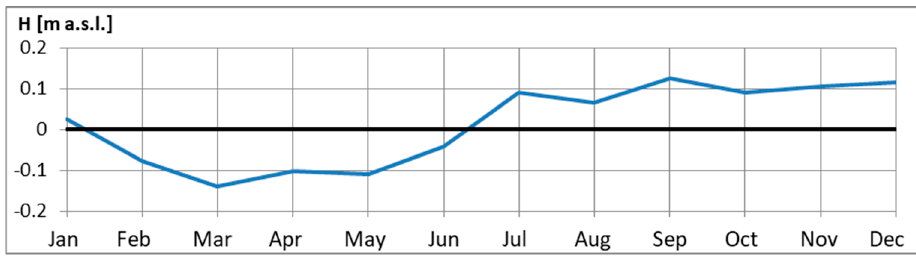
Figure 2. Monthly distribution of the percentage of SW (225°–285°) and NE (15°–75°) winds [9].